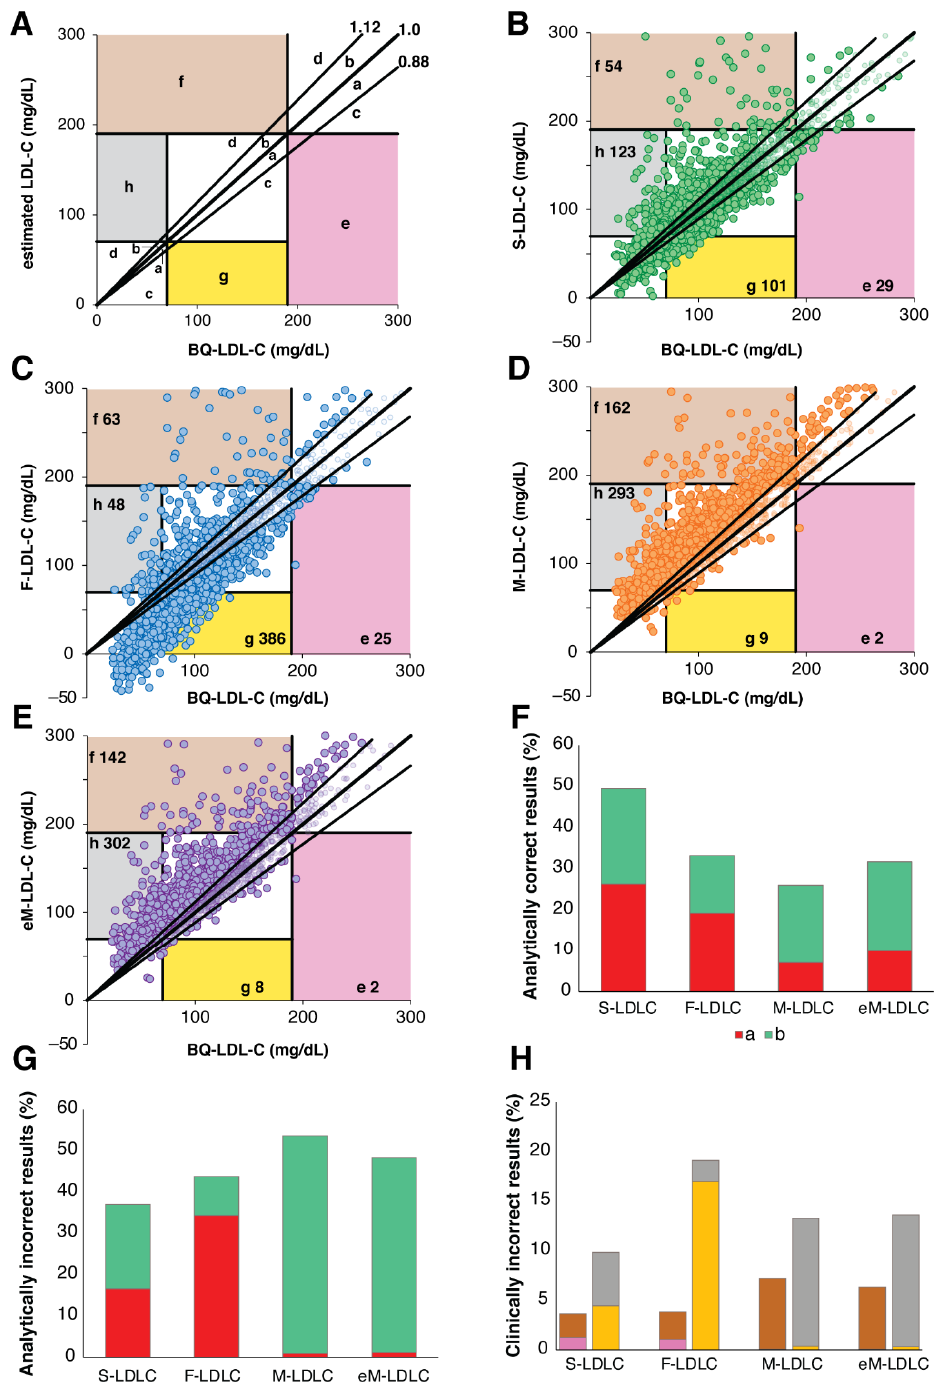
Figure 6. Error Grid Analysis for high TG samples. Definition of type of errors are shown in (Panel A ). a: Within 12% proportional error and below regression line, b: Within 12% proportional error and above regression line, c: Greater than 12% proportional error but no impact on patient management and below regression line, d: Greater than 12% proportional error but no impact in patient management and above regression line, e: Underestimation of LDL-C at high LDL-C cut-point leading to error in patient management, f: Overestimation of LDL-C at high LDL-C cut-point leading to error in patient management, g: Underestimation of LDL-C at low LDL-C cut-point leading to error in patient management, h: Overestimation of LDL-C at low LDL-C cut-point leading to error